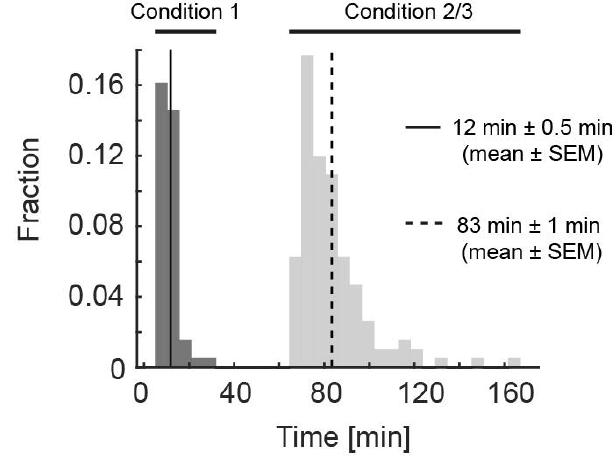
Figure S2. Duration of recording sessions. Related to Figure 2. Histogram of the durations of the recording sessions. On average, one recording session lasted for approximately 12 min during condition 1 (solid line) and, due to the addition of closed-loop, open-loop, and grating stimulation phases, 83 min during conditions 2 and 3 (dashed